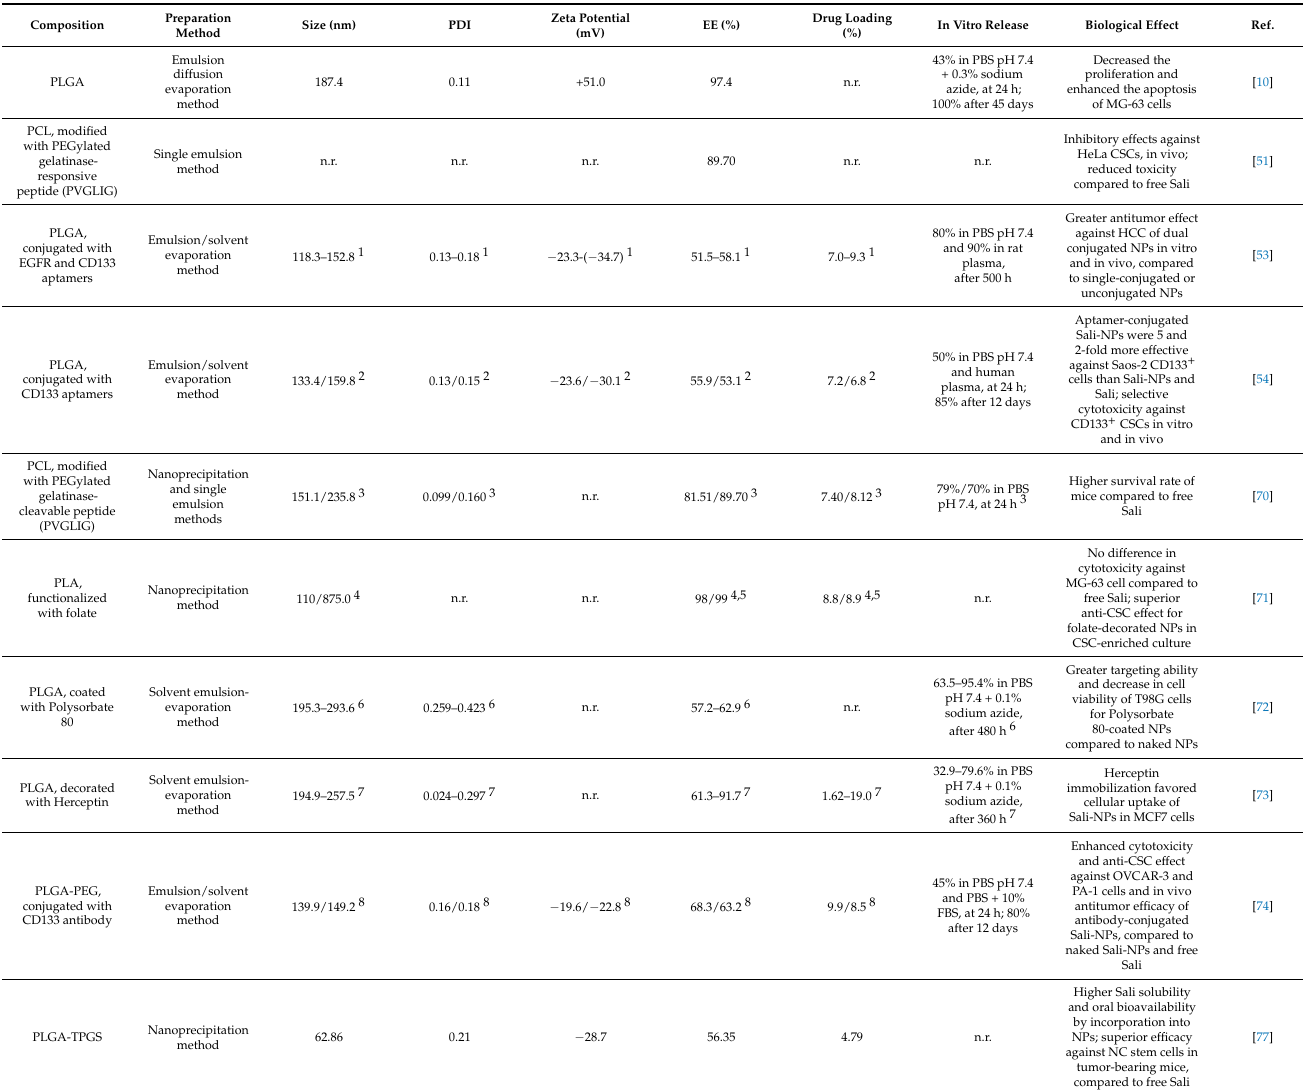
Table 4. Polymeric nanoparticles with